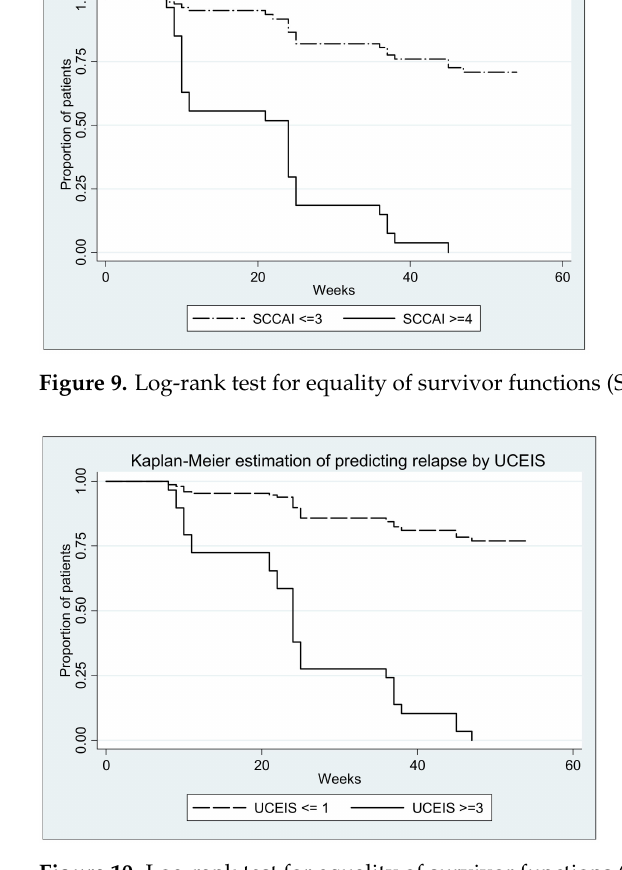
Figure 10. Log-rank test for equality of survivor functions (UCEIS) p < 0.00001. On multivariate Cox proportional hazard analysis, a relapse was associated indepen- dently with the extension of the disease (E2-E3), increased FC level, C reactive protein, hemoglobin concentration, SCCAI index and UCEIS score (Table 3). Table 3. Hazard ratio (HR) of parameters associated with relapse ( n =